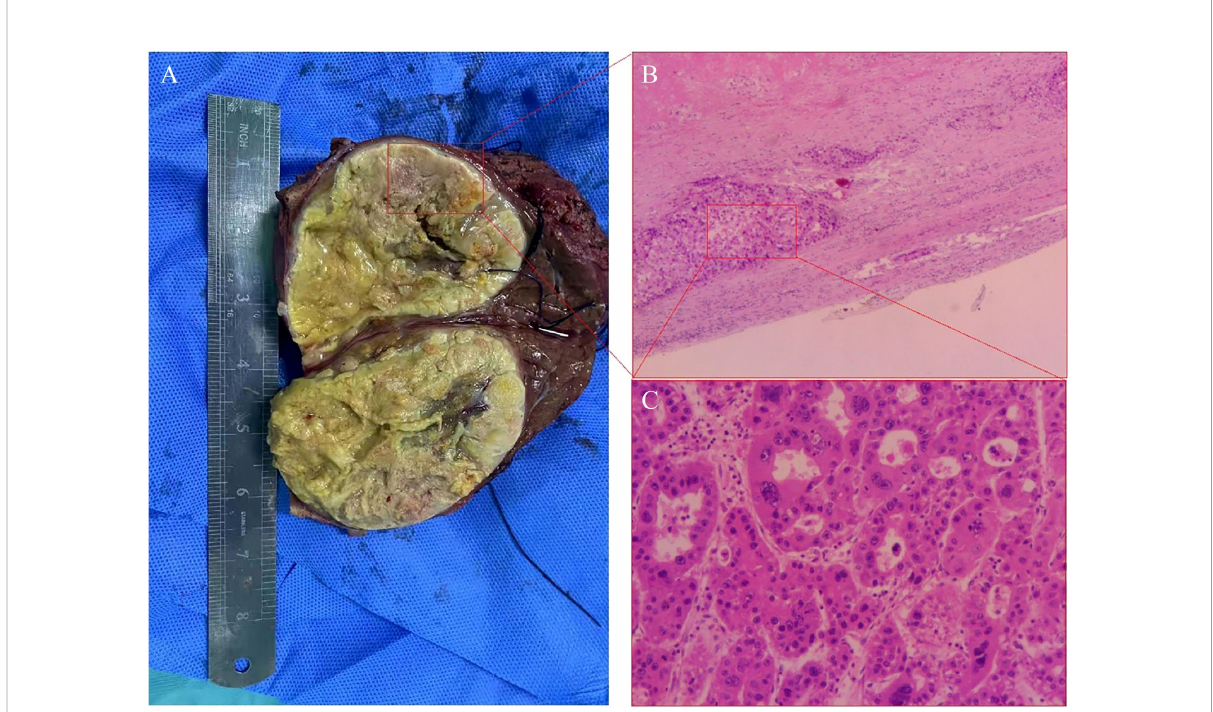
FIGURE 3 Histopathology of tumor tissue in Case 2 after conversion therapy and resection. (A) Viable cancer cells were observed (inside the red box), as well as necrotic cells (outside the red box). (B) The primary lesion showed massive necrosis with lymphocyte in fi ltration, and scattered tumor cell nests surviving around the lesion (red box). Magni fi cation, 40x. (C) Higher-magni fi cation image of the red box in panel (B) shows some degenerated tumor cells and some giant tumor cells. Magni fi cation, 100x.